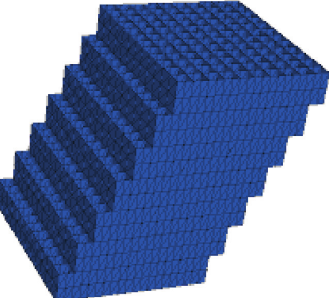
Figure 2: Layout of the